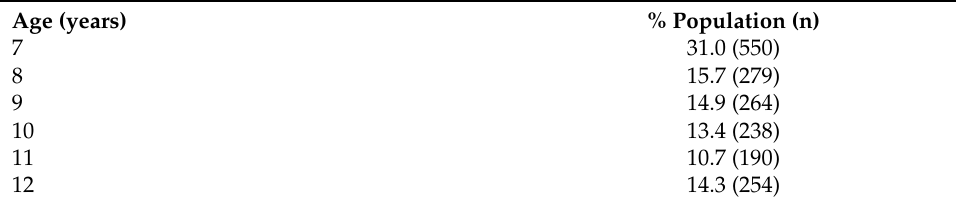
Table 1. Characteristics of the